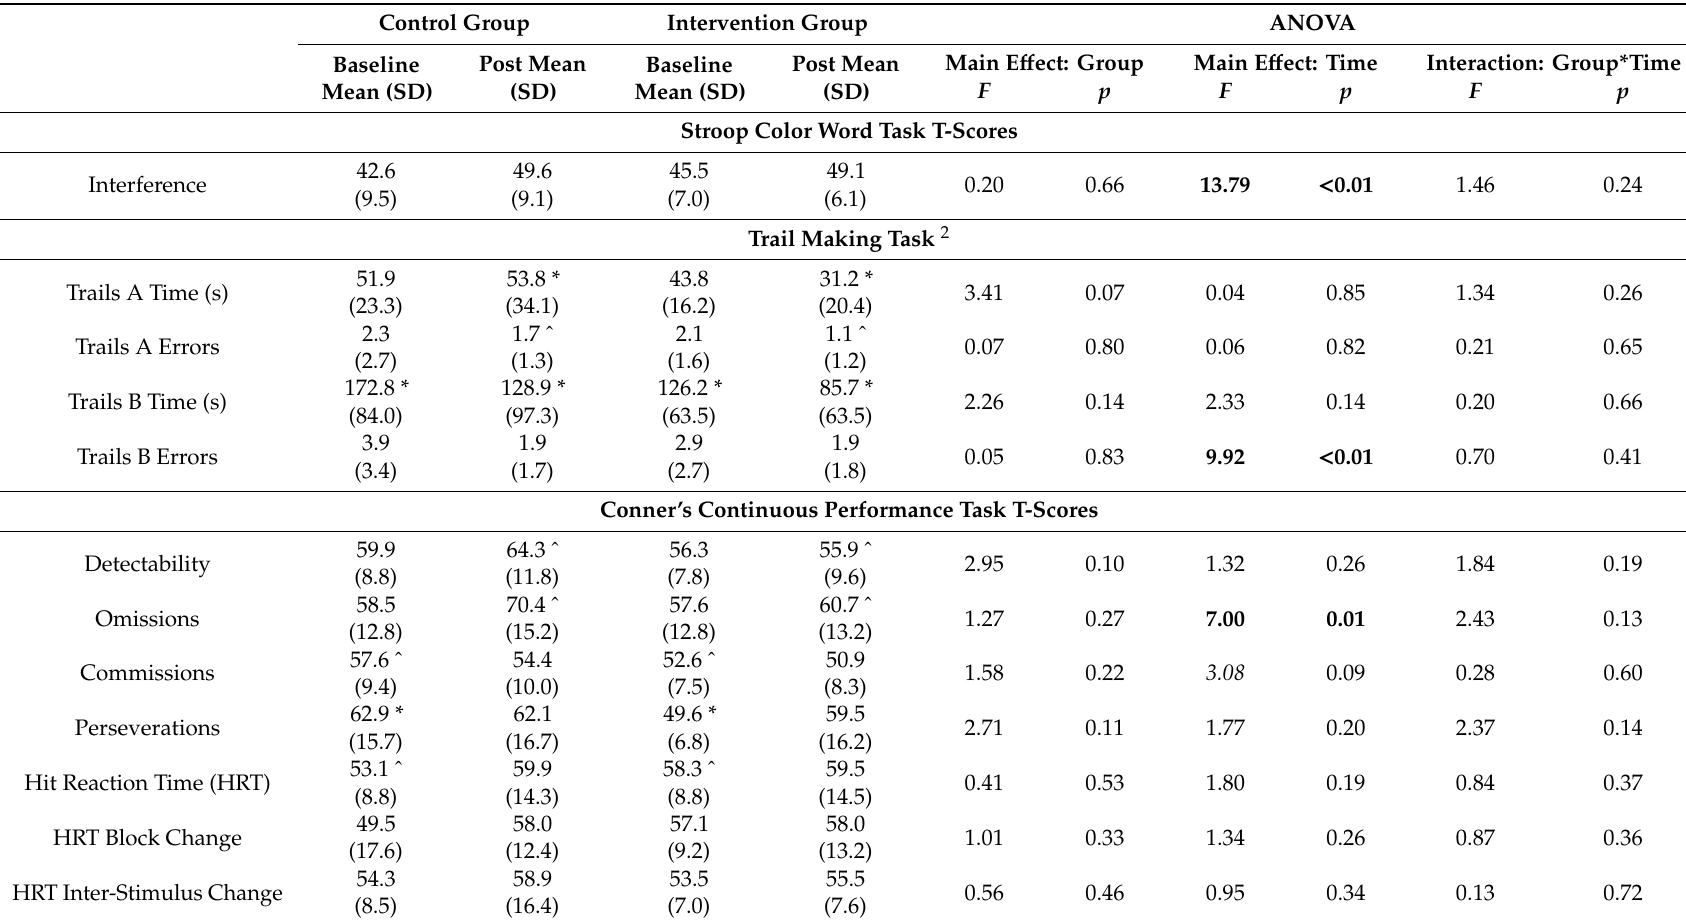
Table 2. Cognitive Scores among Students Participating in a feeding trial 1 at baseline and post-implementation: Analyses of Variance (ANOVA)